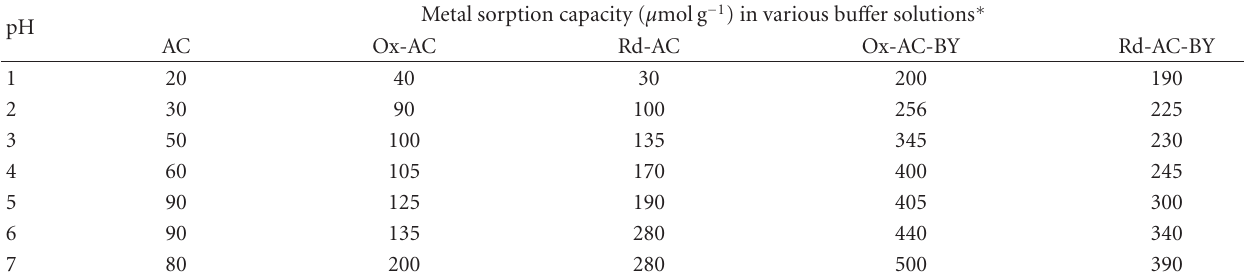
Table 2: Sorption capacity values of lead by modified active carbon sorbents in various bu ff er solutions.